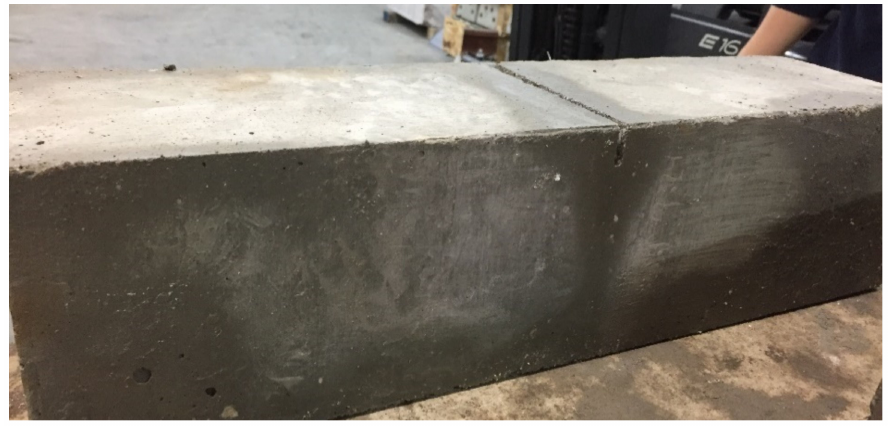
Figure 4. Fatigue